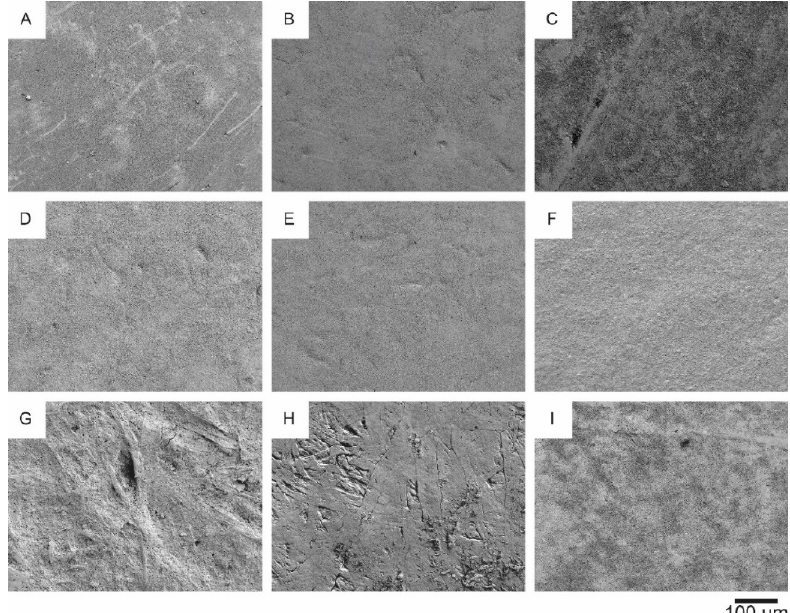
Figure 9. SEM images at a magnification factor of 200 of the following substrates: p_e:smart paper type 2 ( A ), Parade Label A ( B ), Incada Exel ( C ), Koehler Type E ( D ), Algro Baress ( E ), Magno Satin ( F ), Silvaboard ( G ), PG90 ( H ), UPM Finesse Premium Silk H 90 ( I ).